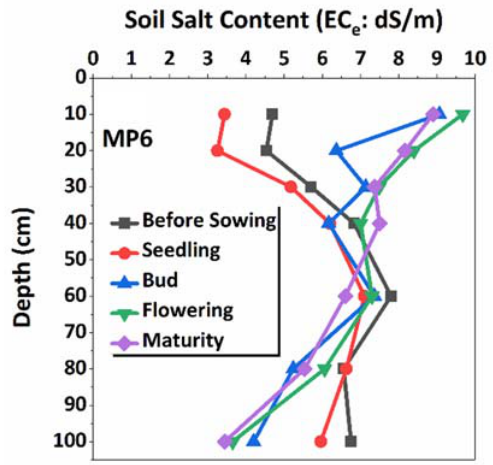
Figure 11. Dynamic of soil salt content in micro ‐ plot 6.